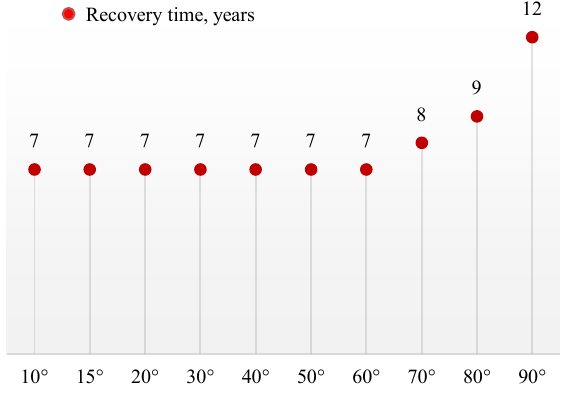
Fig. 6. PBT in year at different roof